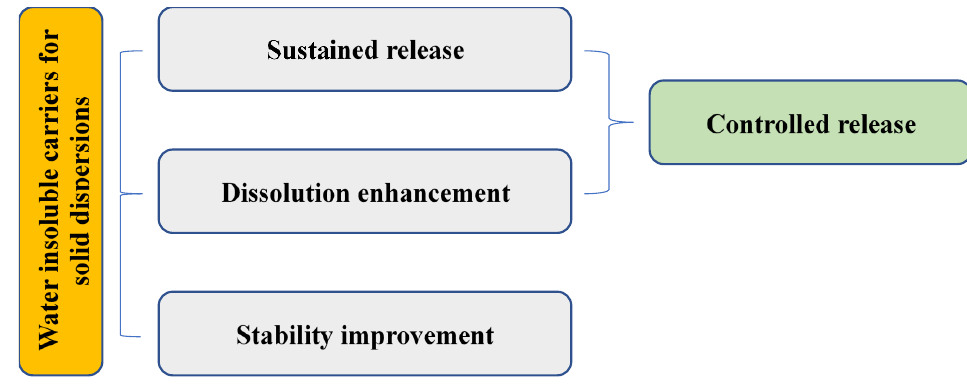
Figure 4. Illustration of applications of water-insoluble carriers in SDs.